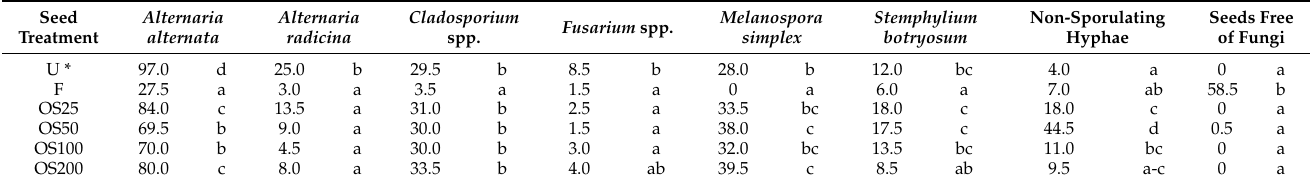
Figure 6. Alternaria radicina on carrot seeds ( a ) and spores ( b ). Table 4. Effects of osmopriming with the addition of melatonin on the incidence of fungi on D. carota ‘Amsterdamska’ seeds of sample II and seeds free of fungi